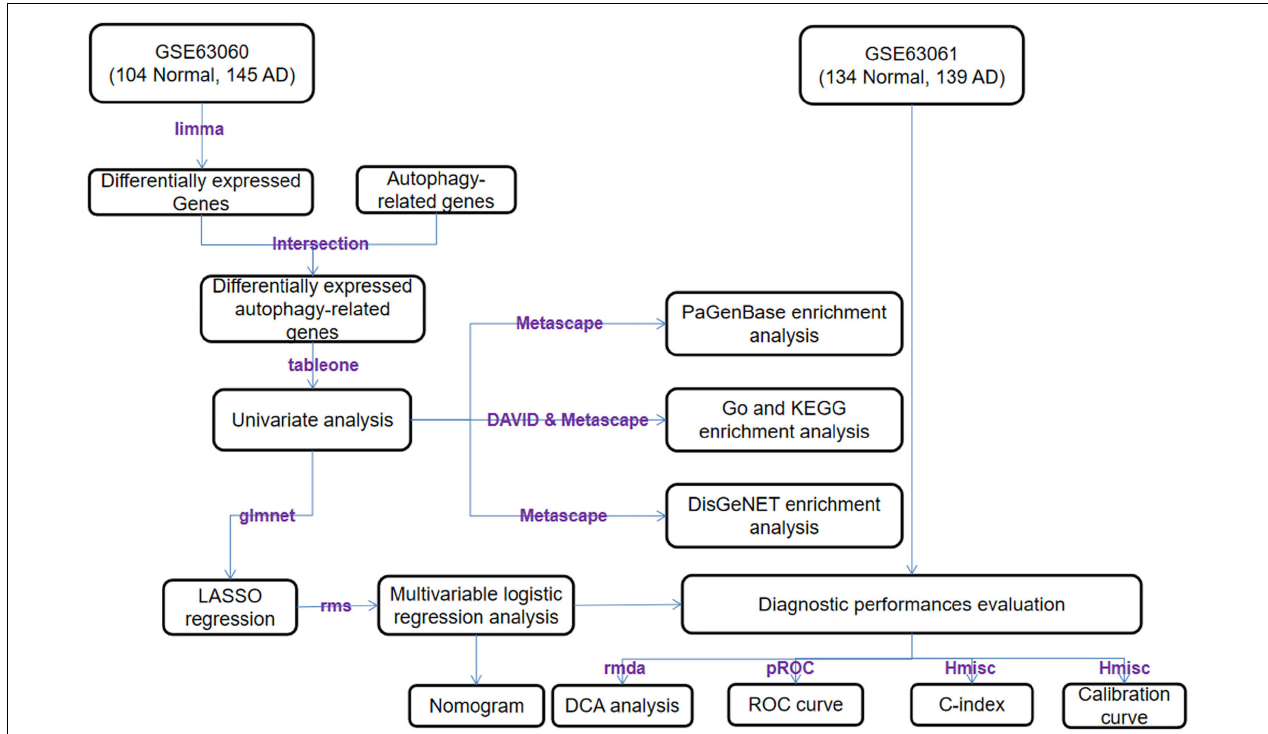
FIGURE 1 | Overview of the